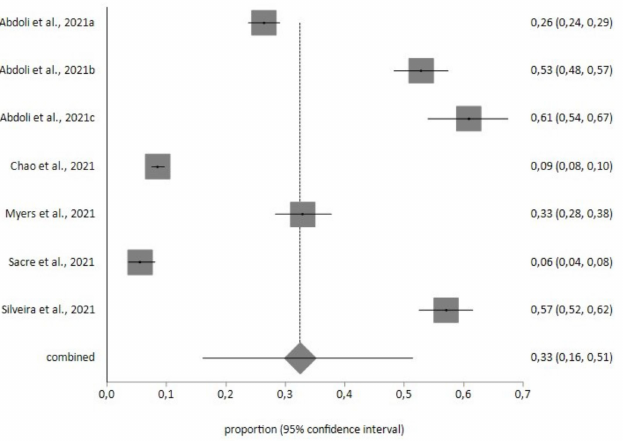
Figure 3. Prevalence of depression in diabetic patients determined using the Patient Health Questionnaire—8 items